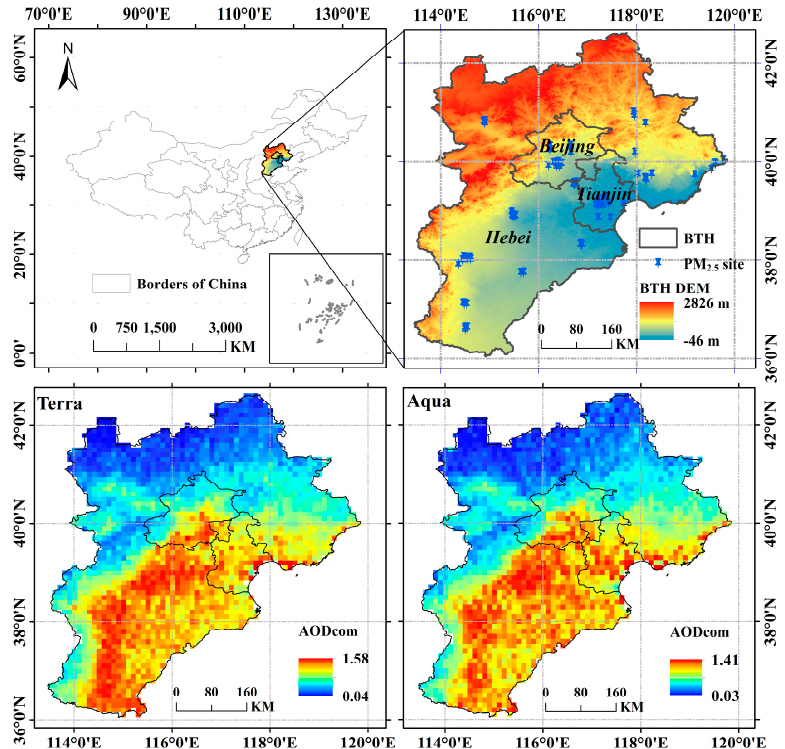
Figure 1. Topography and spatial distribution of PM 2.5 monitoring stations ( upper-right ) and annual mean “AODcom” maps ( bottom-left for the Terra satellite and bottom-right for the Aqua satellite) of the Beijing–Tianjin–Hebei (BTH) region. A histogram equalization contrast stretch was applied in these maps.